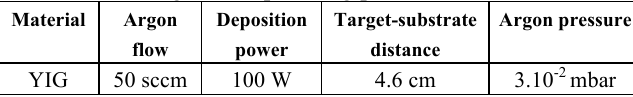
Table 1: RF magnetron sputtering parameters for YIG